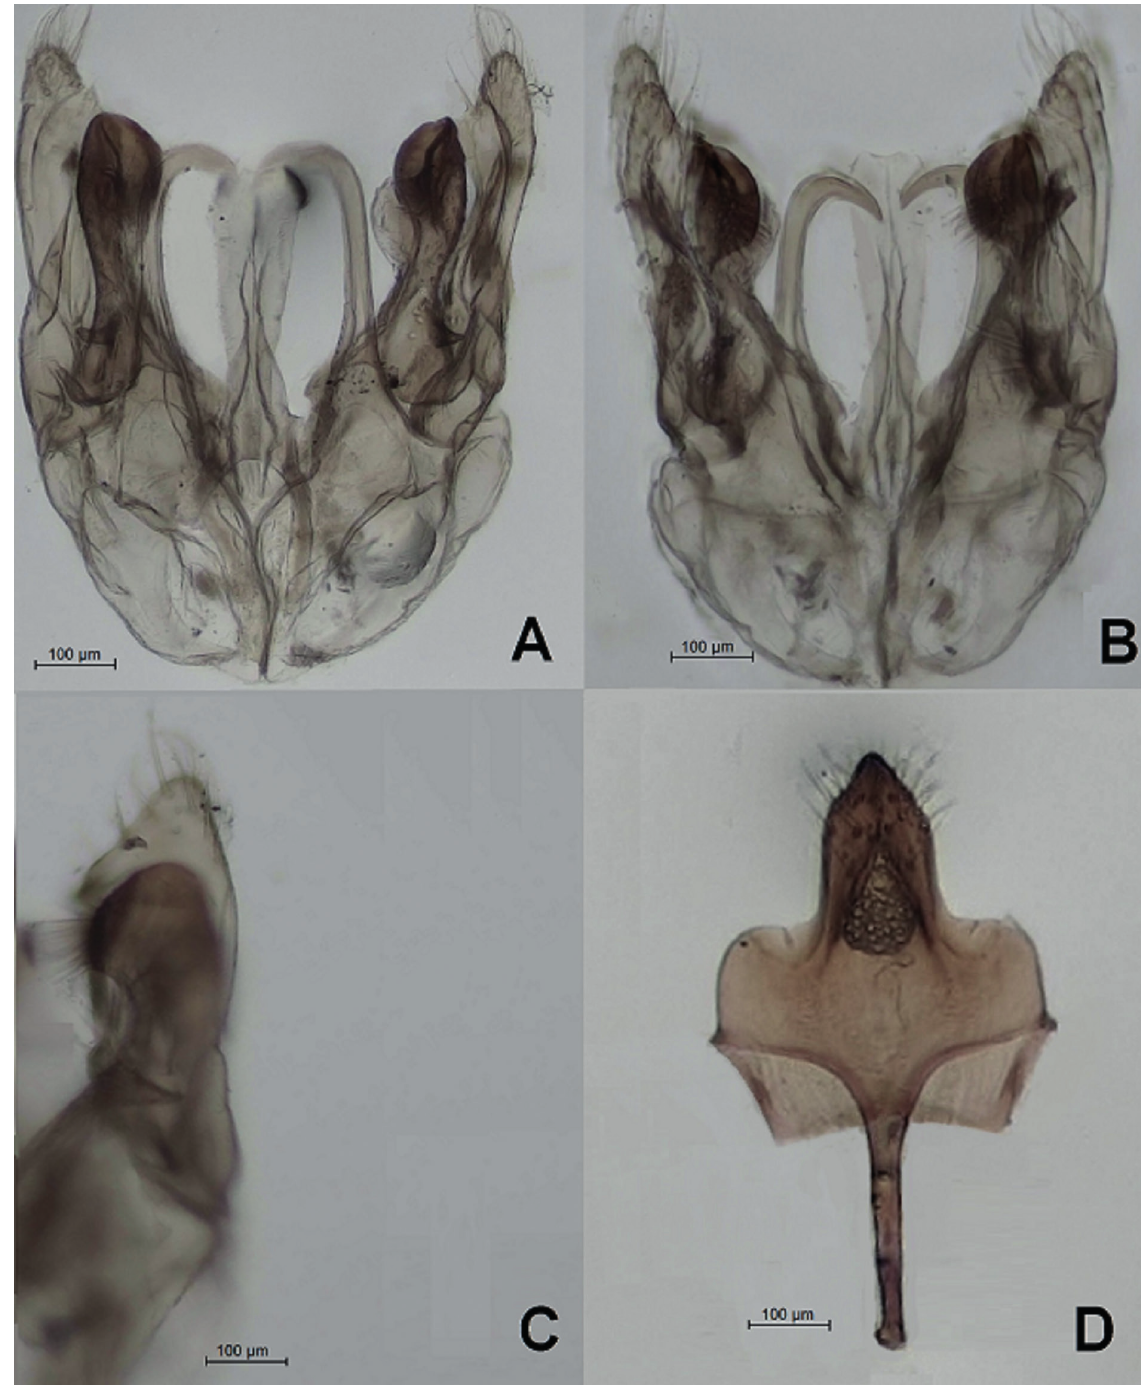
Fig. 4. Ageniella caerulea sp. nov., ♂, allotype (INPA). A . Genitalia, ventral view. B . Genitalia, dorsal view. C . Paramere, lateral view. D . Hypopygium, frontal